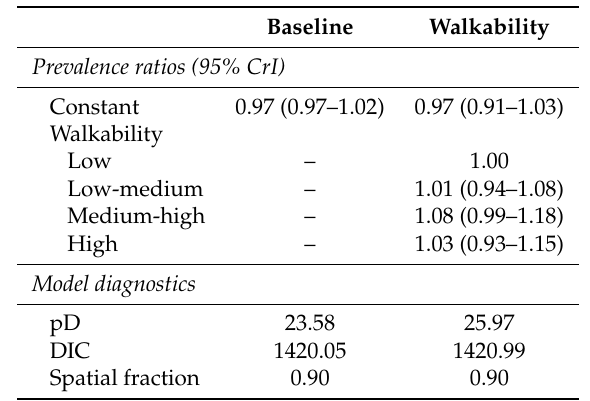
Table 4. Conditional auto regression model summaries for sensitivity